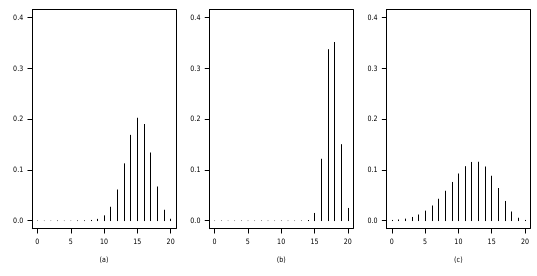
( θ ) } , in panel (a), where m = 20 and θ = 0.75, i ( θ , α ) } , for m = 20, θ = 0.75, and α = 7.8, in panel (b), and i